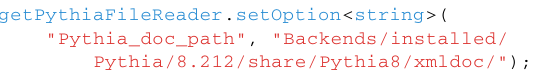
SpecBit ’s MSSM_spectrum [40] capability. Each of the decay_rates can be provided by DecayBit [40]. These functions have no options to be specified in the YAML